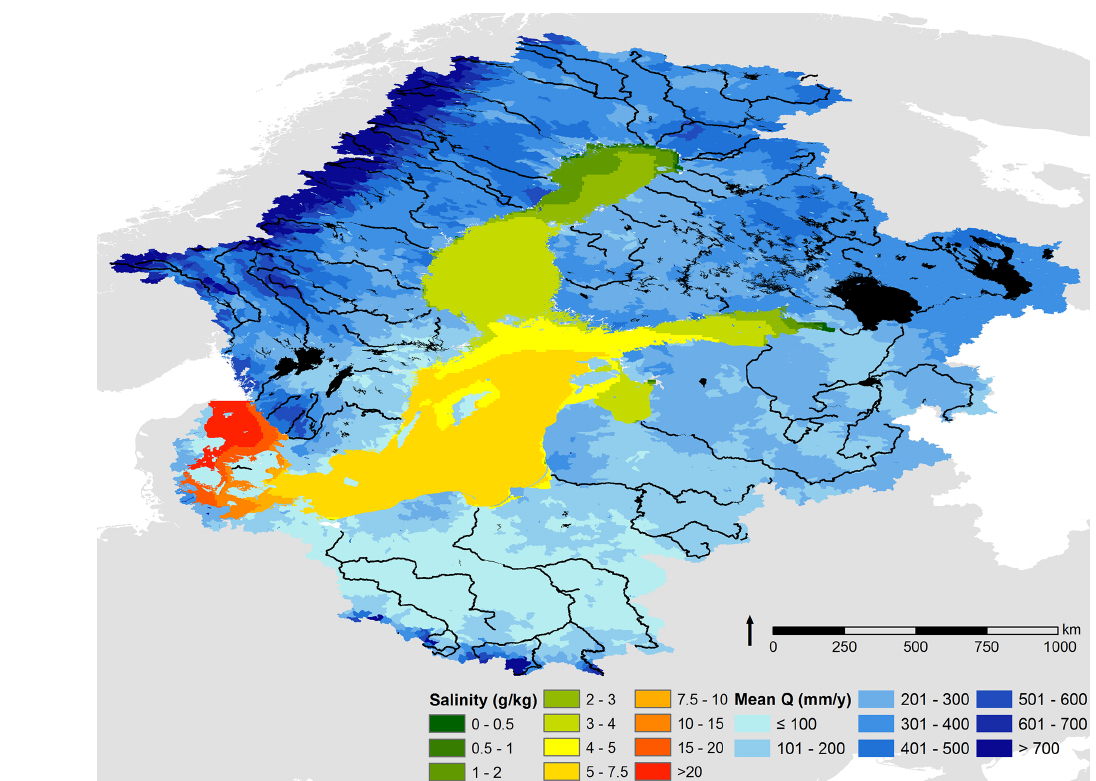
Figure 1. The Baltic Sea and its catchment area, with the climatological mean salinity (in grams per kilogram; hereafter gkg − 1 ) and river runoff (in millimetres per year; hereafter mmyr − 1 ) shown. Source: Meier et al.,